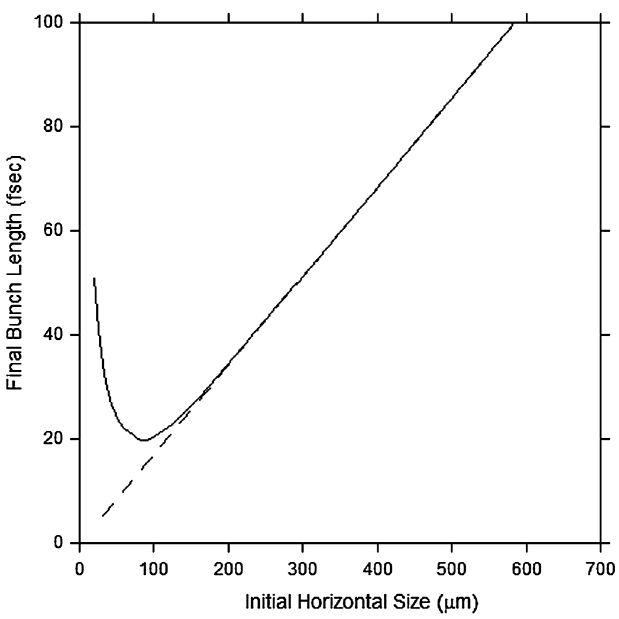
FIG. 3. Final bunch length for the nominal beam with a 0.25-ps initial bunch length as a function of initial transverse beam size for a standard EEX geometry (case A—solid line) and for case B (dashed